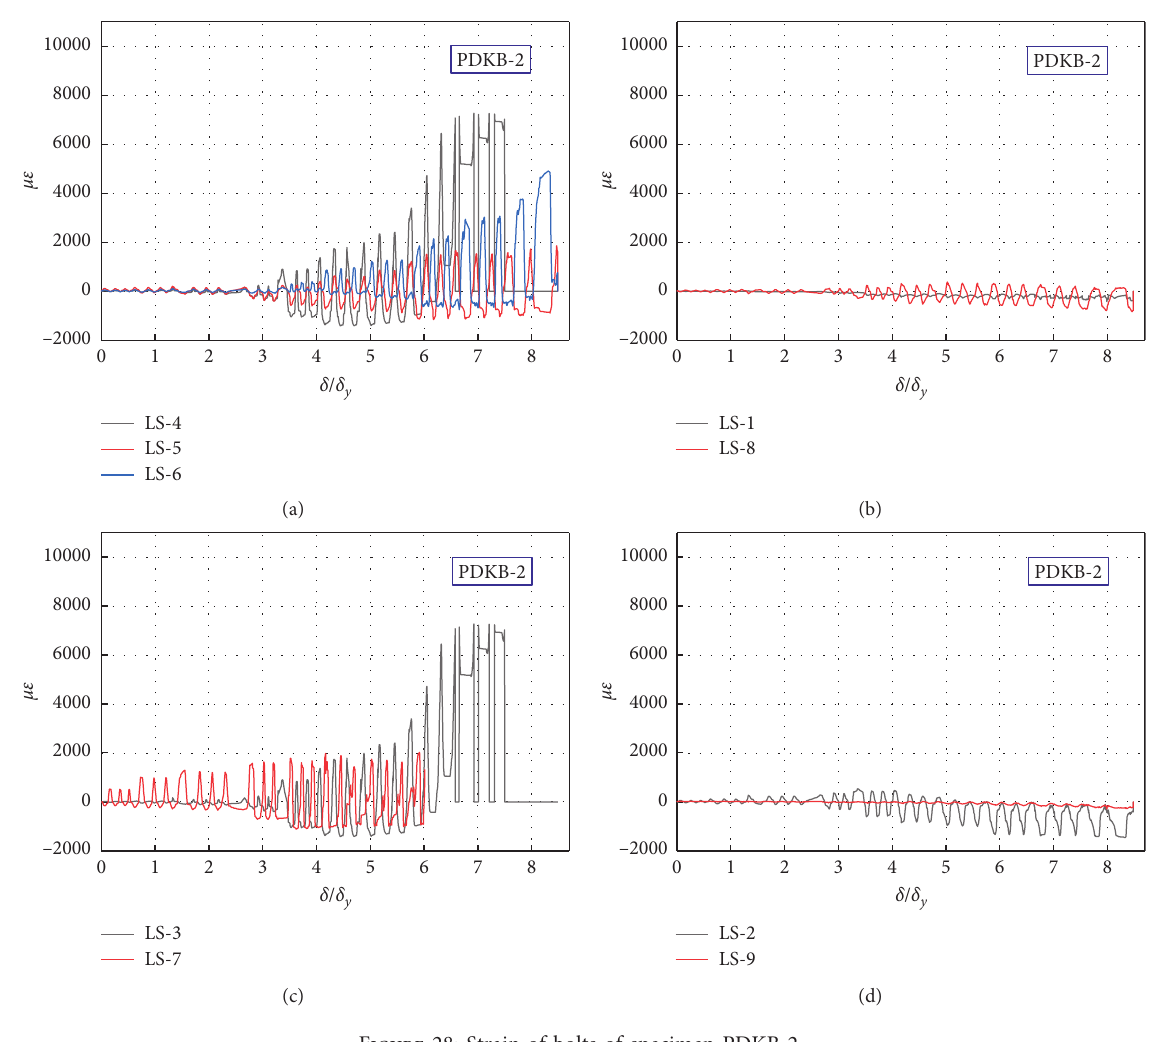
Figure 28: Strain of bolts of specimen